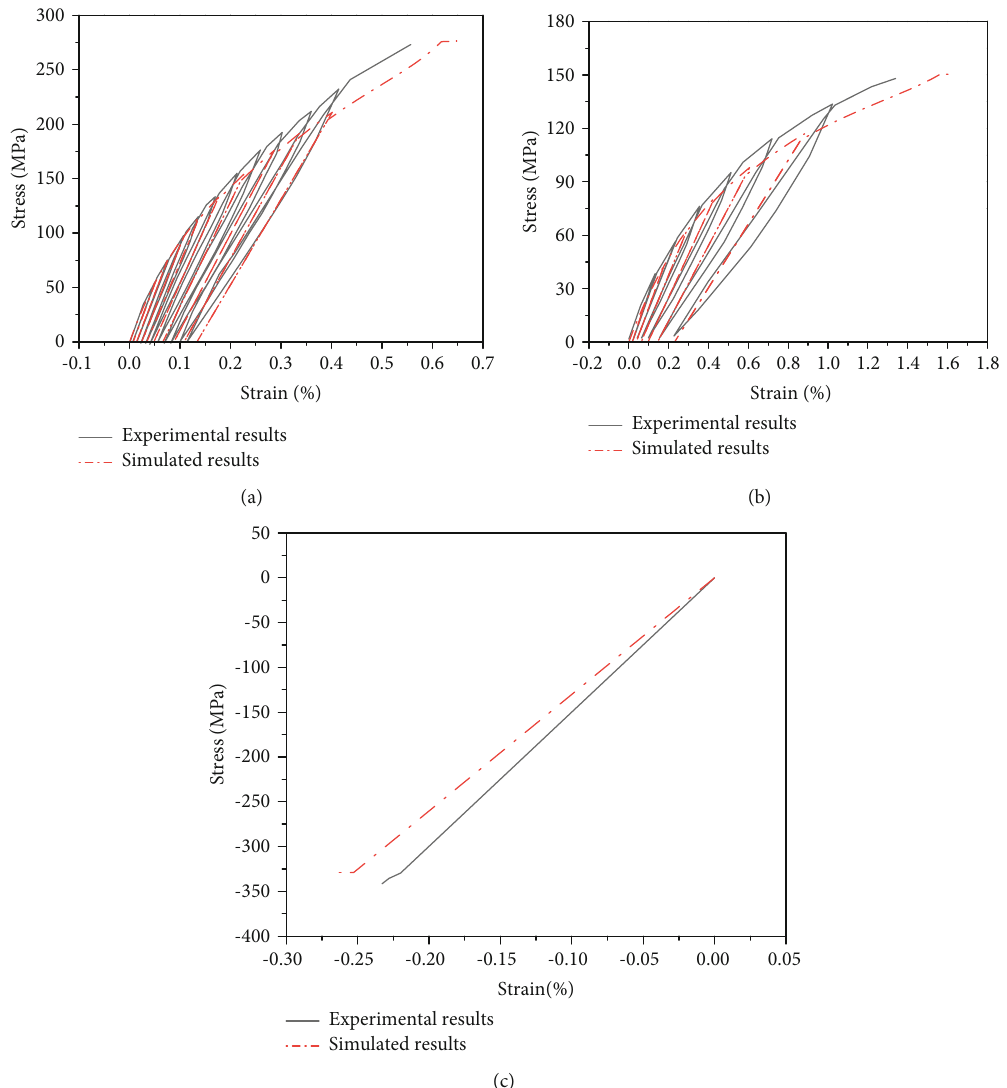
Figure 4: Comparison of simulated stress and strain relations with experimental results under tensile (a) and shear (b) loading/unloading and uniaxial compressive loading (c) processes of the 2D C/SiC composite samples in Li